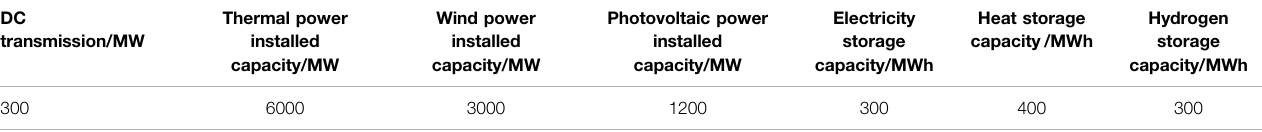
TABLE 1 | Parameters of the power grid with multi-energy